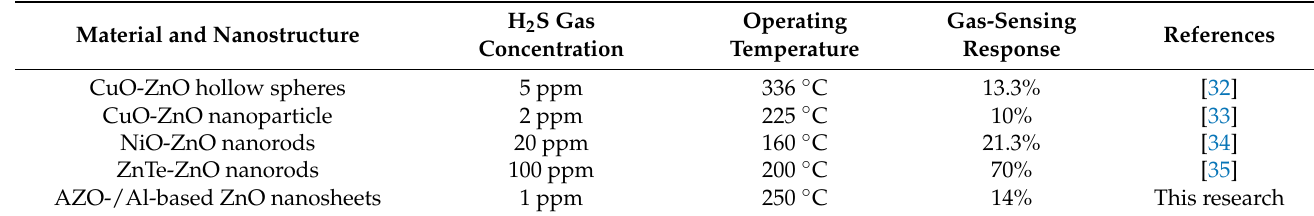
Table 1. Comparison of current research with previous